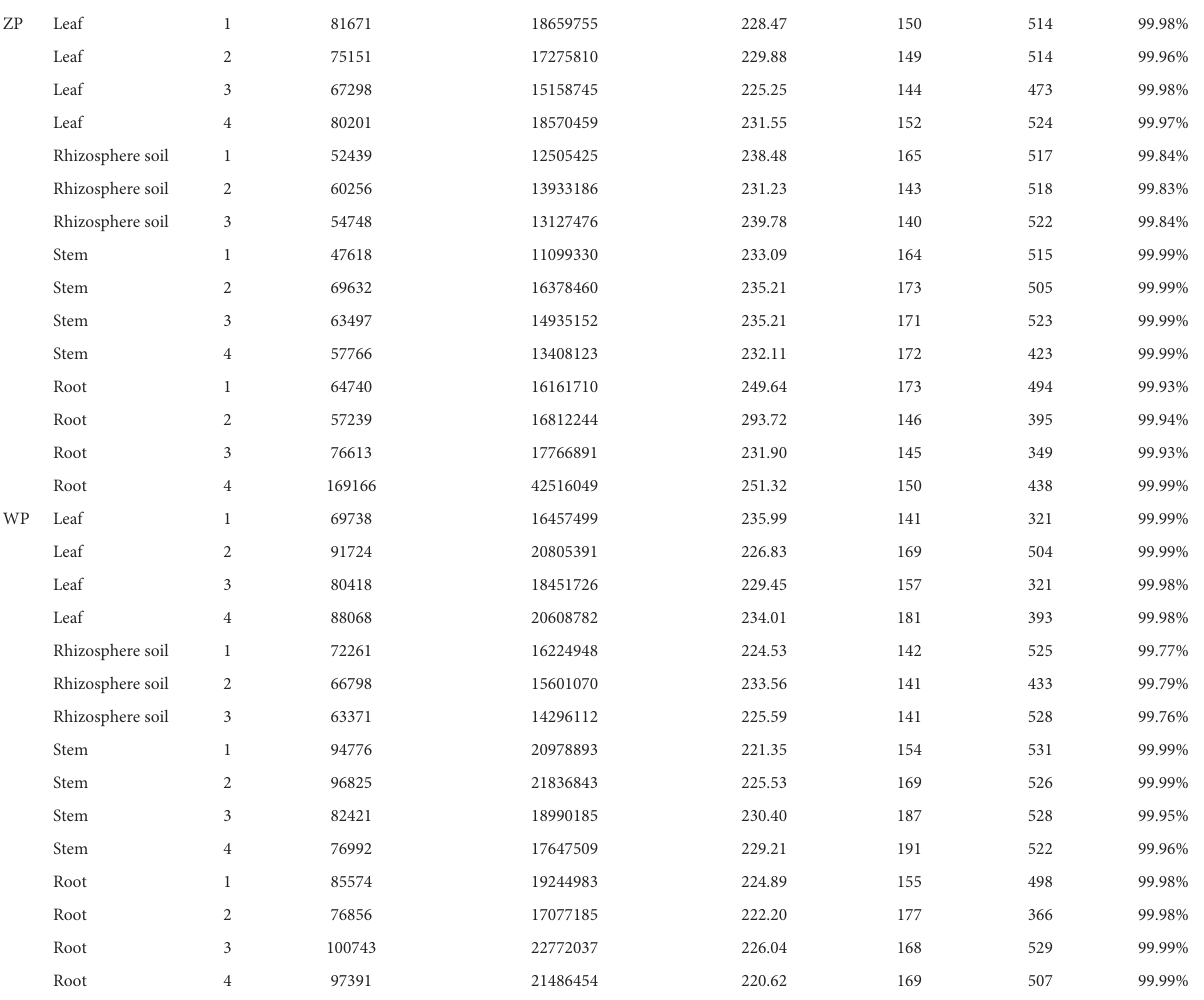
TABLE 5 Sequencing